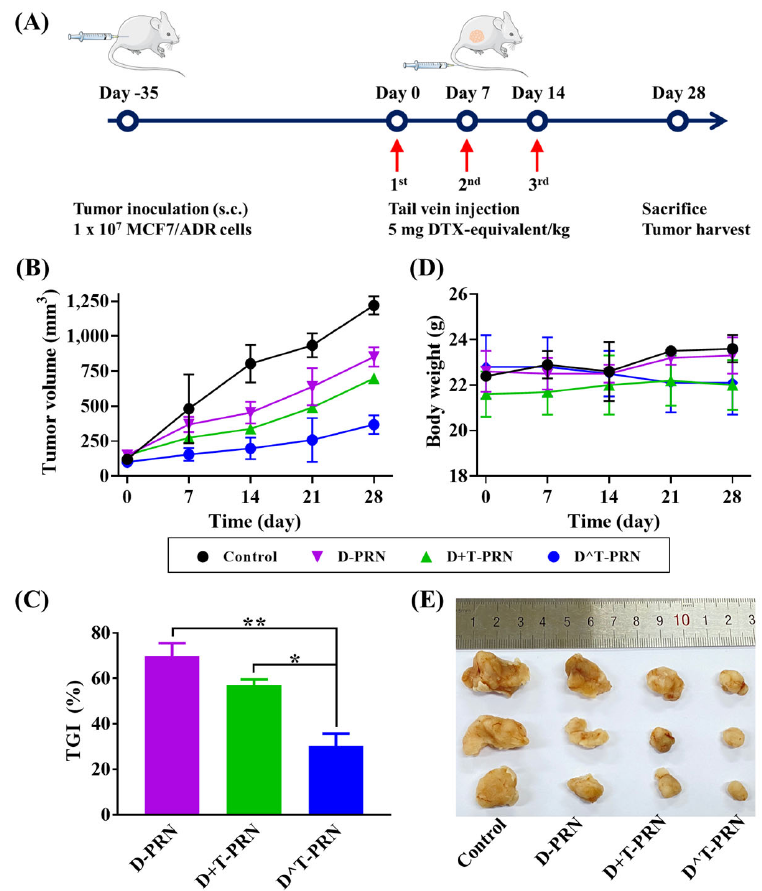
Figure 8. In vivo antitumor efficacy in an MCF7/ADR-xenograft mouse model. ( A ) Schematic representation of the in vivo treatment schedule after the tail vein injection of different formulations at a 5 mg docetaxel (DTX)-equivalent/kg dose on days 0, 7, and 14, for a total of three injections per mouse. ( B ) Changes in tumor volume over 28 days after administration. ( C ) Tumor growth inhibition (TGI) on Day 28. ( D ) Changes in body weight. ( E ) Morphology of excised xenograft tumors at the end of the study (Day 28). Data are the mean ± SD ( n = 3). The differences were significant at * p < 0.005 and ** p < 0.001.